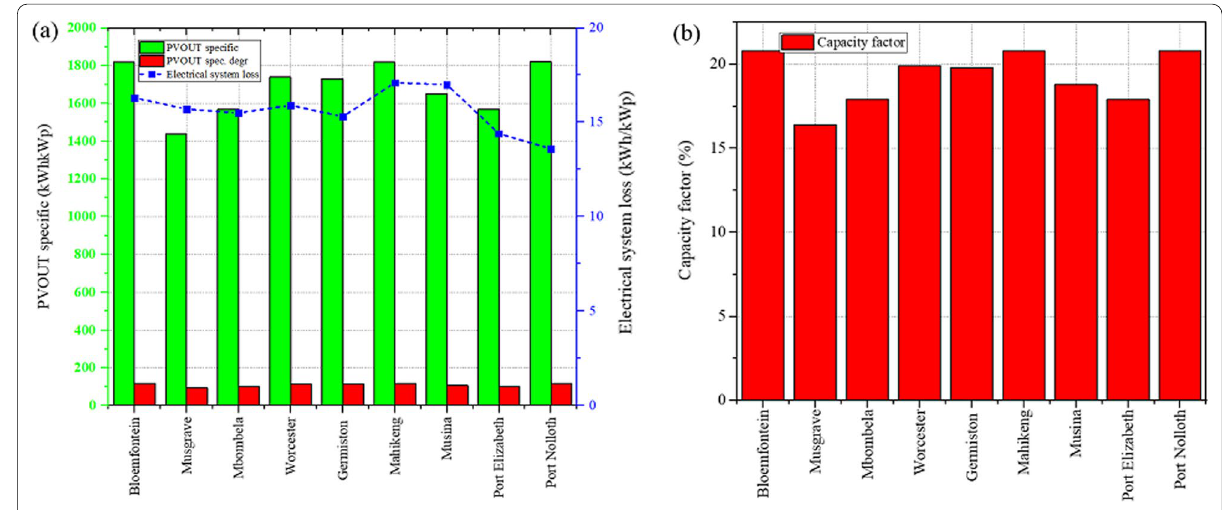
Fig. 10 a Energy-related losses; b capacitor factor